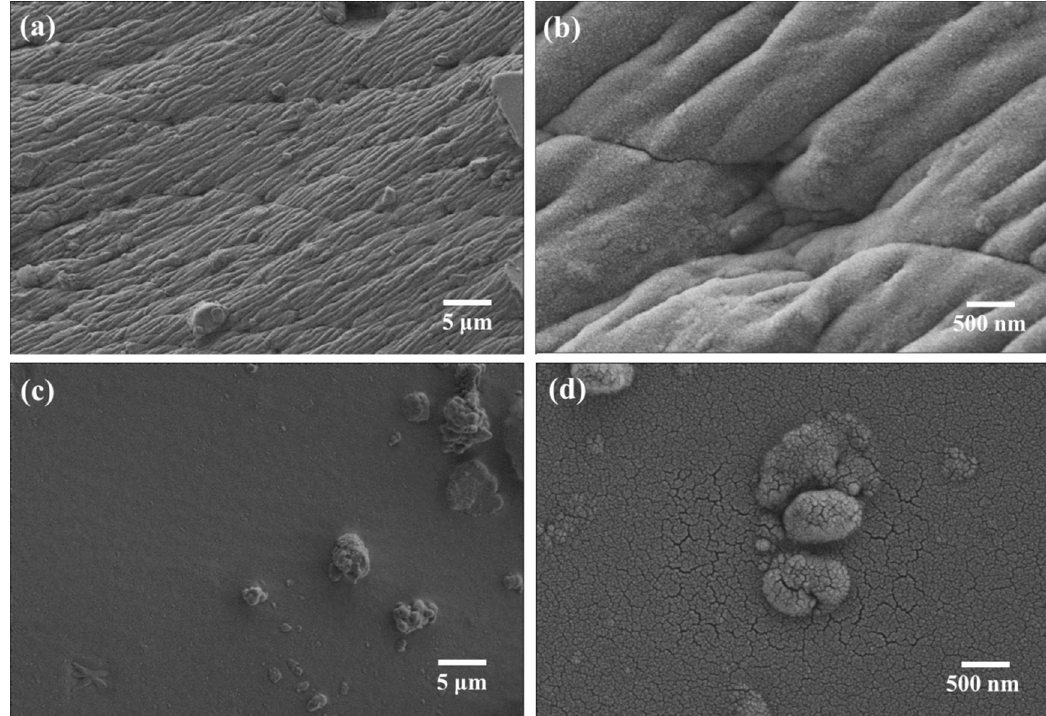
Figure 2. XPS spectra of the hydrogel HMN ‐ 4.